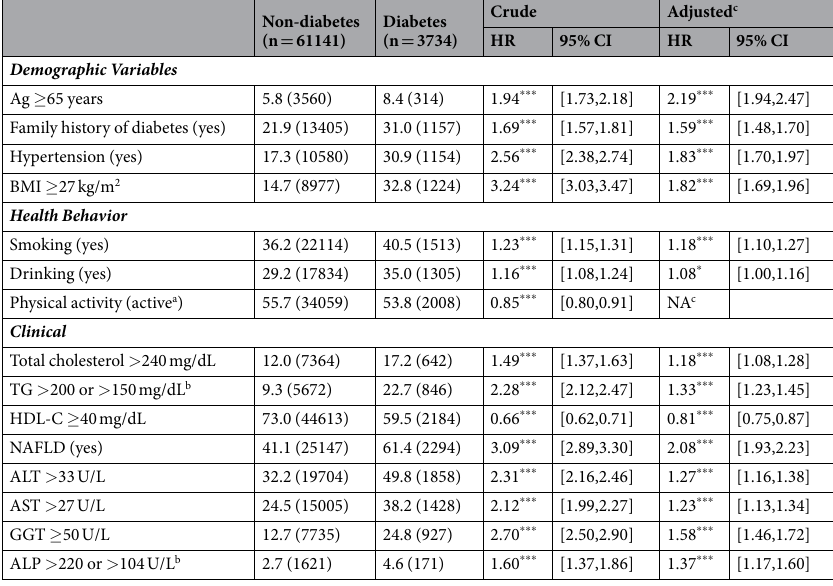
Table 2. Cox regression analysis of type 2 diabetes in men. The values were described as frequency (n). * p < 0.05, ** p < 0.01, *** p < 0.001. 95% CI in brackets. Abbreviations: FPG, fasting plasma glucose; TG, triglycerides; HDL-C, high-density lipoprotein cholesterol; NAFLD, non alcoholic fatty acid disease; ALT, alanine transaminase; AST, aspartate transaminase; GGT, gamma-glutamyltransferase; ALP,